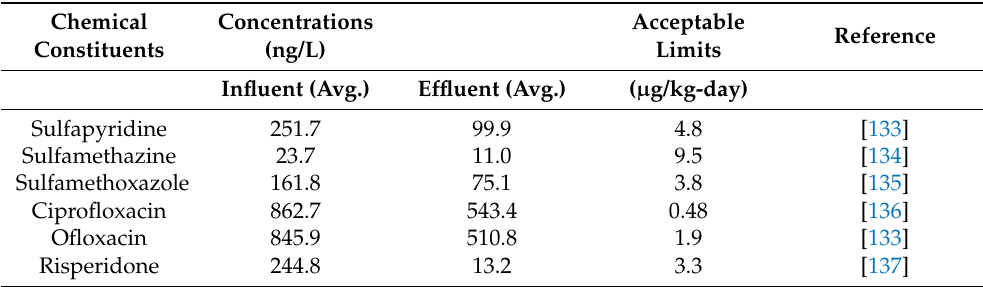
Table 11. Identification of pharmaceuticals (antibiotics) present in the influents and effluents